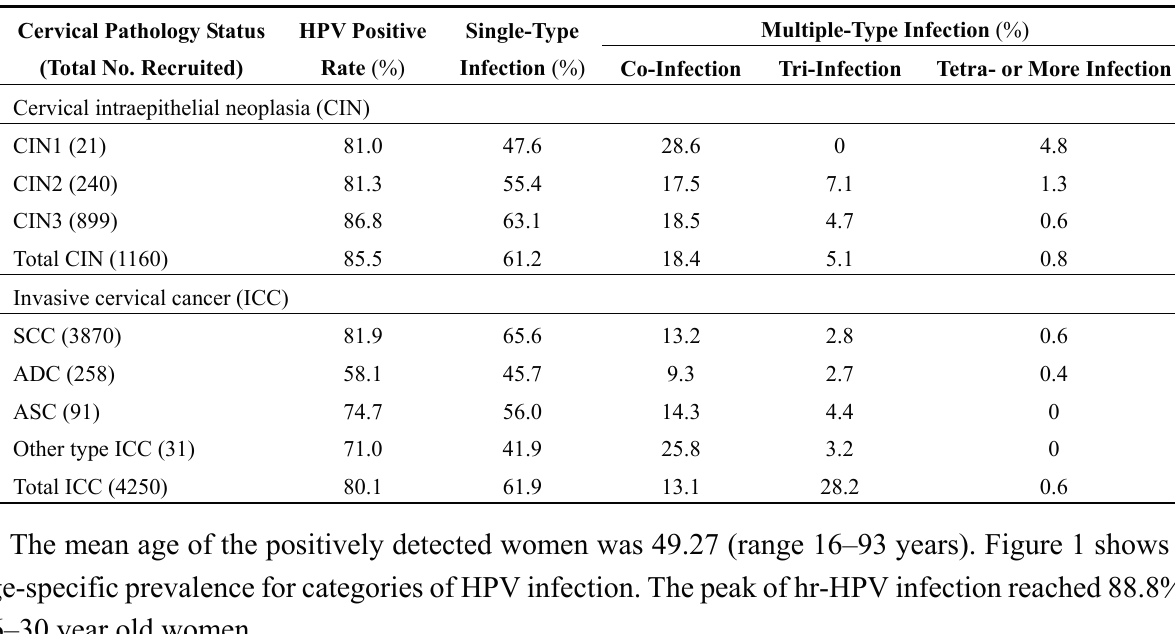
Table 1. Detection of HPV and proportion of multiple-type infection according to cervical pathology status.